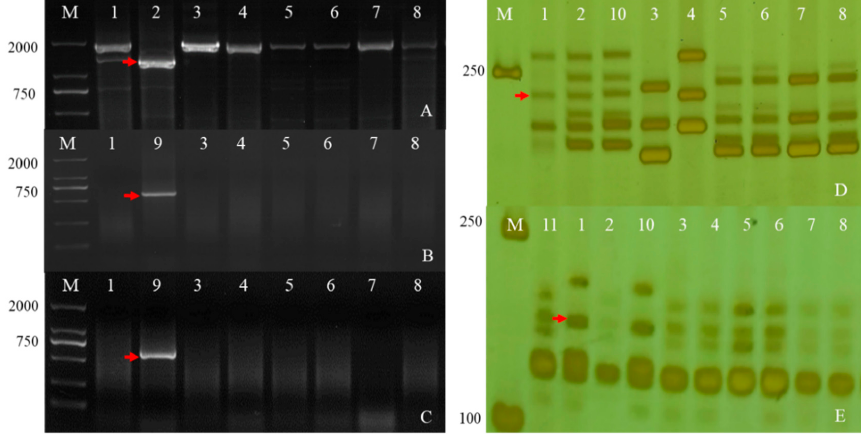
Figure 6. Detection Fhb1 ( A ), Fhb7 ( B , C ), Fhb5 ( D ) and Fhb4 ( E ) using the markers TaHRC-STS , F7-1 , F7-7 , Xgwm304 and Xgwm149 . The red arrows indicate Fhb-specific bands. (M). DL2000. (1). CS. (2). Sumai3. (3). SY159. (4). W166. (5). Abbondanza nullisomic line 7A. (6). Abbondanza nullisomic line 7B. (7). W623. (8). W637. (9). Th. Elongatum. (10). Wangshuibai. (11). Aikang58. (a Chinese wheat cultivar).